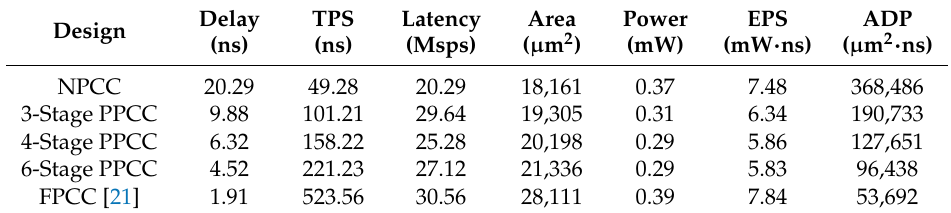
Table 5. Performance comparison of the conventional and cascaded CORDIC algorithms based on synthesis results for unknown rotation angles ( N = L =